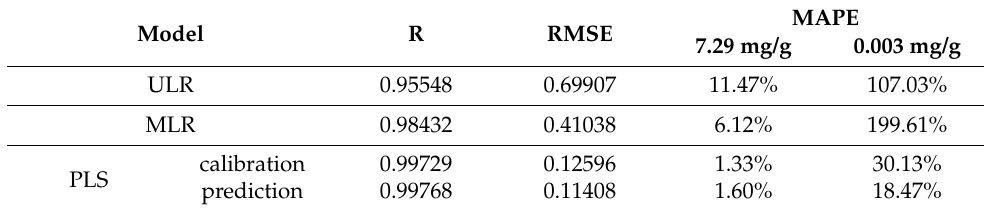
Table 1. Comparison of three quantitative